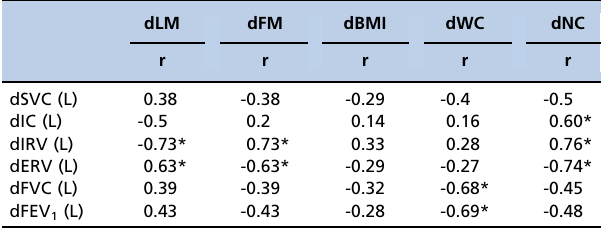
Table 5 - Correlations among lung function, body composition and anthropometric